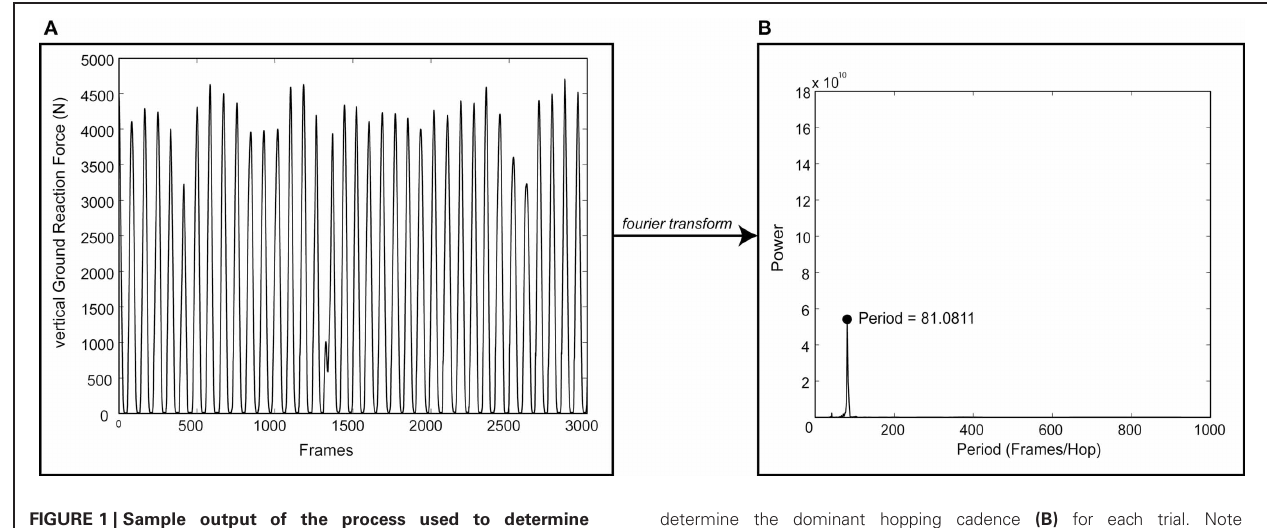
FIGURE 1 | Sample output of the process used to determine dominant hopping cadence. A discrete Fourier transform was applied to vertical ground reaction force data ( v GRF, A ) to